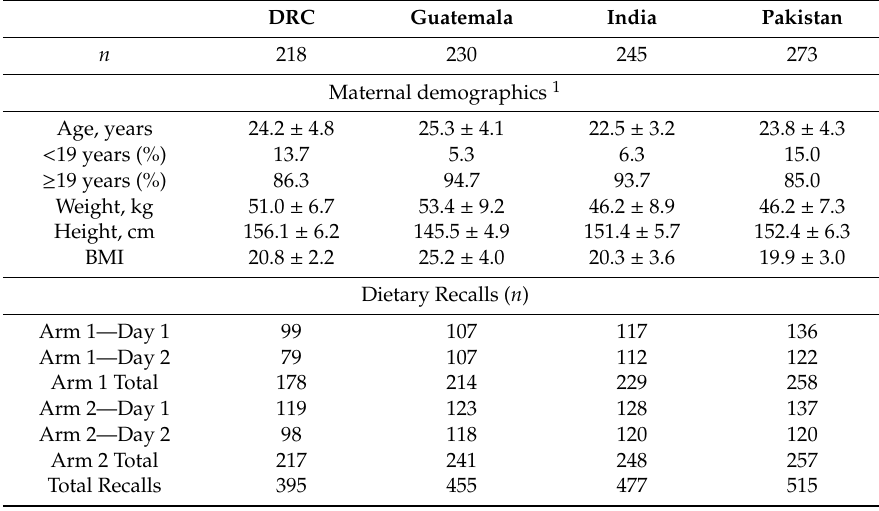
Table 1. Maternal demographics at 12-week gestation and dietary recalls by study arm in four low- and middle-income